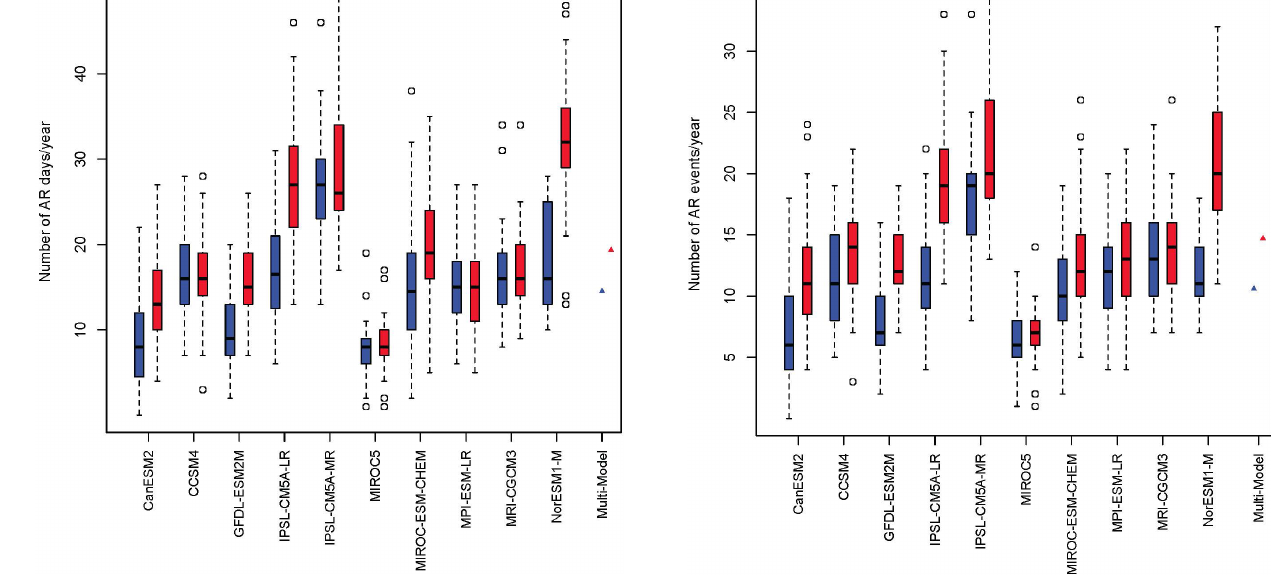
Figure 3. Boxplot summaries of annual numbers of atmospheric river events (AR frequency, unit: eventsyr − 1 ) for the California re- gion from each CMIP5 model during the 25 years, spanning 1981– 2005 (blue boxplot) and 2076–2100 under RCP8.5 (red boxplot). Blue and red triangles represent the ensemble mean of AR counts for the historical and RCP8.5 runs,